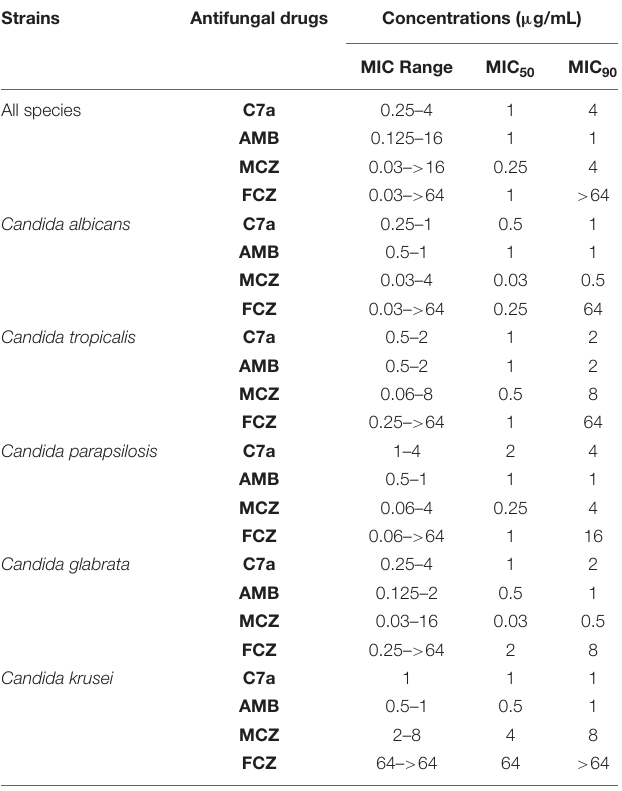
TABLE 1 | Values of minimum inhibitory concentration (MIC, expressed in µ g/ml) of the C7a, AMB and MCZ and FCZ determined in clinical isolates of Candida